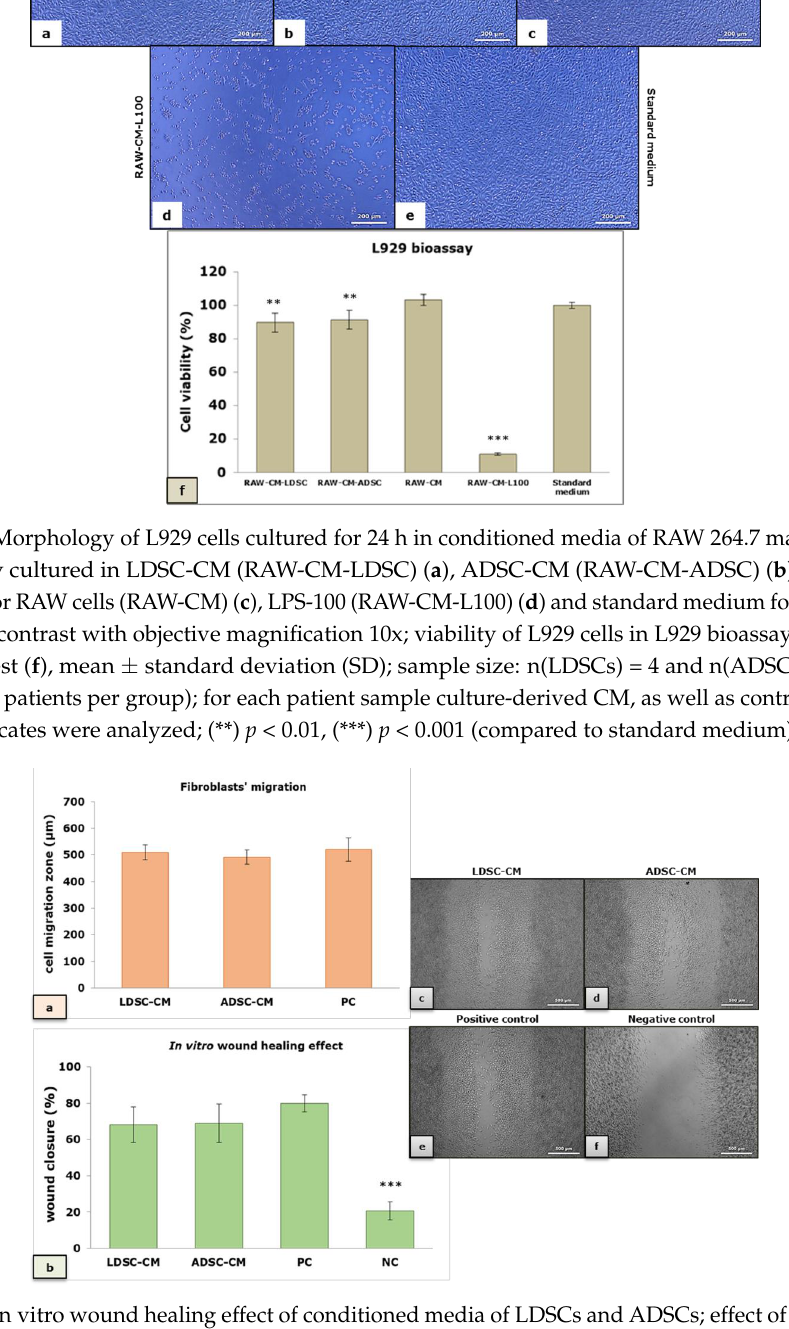
Figure 8. In vitro wound healing effect of conditioned media of LDSCs and ADSCs; effect of LDSC-CM, ADSC-CM, positive (PC) and negative (NC) control on fibroblasts’ migration ( a ) and wound closure ( b ); mean ± standard deviation (SD); sample size: n(LDSCs) = 4 and n(ADSCs) = 4 (n – number of patients per group); for each patient sample-derived CM, as well as controls, four replicates were analyzed; microscopic appearance of the “wound” 3 days after cultivation in LDSC-CM ( c ), ADSC-CM ( d ), positive control ( e ) and negative control ( f ); phase contrast with objective magnification 5 × ; (***) p < 0.001 compared to LDSC-CM, ADSC-CM and PC, no significant difference observed between both CM types and